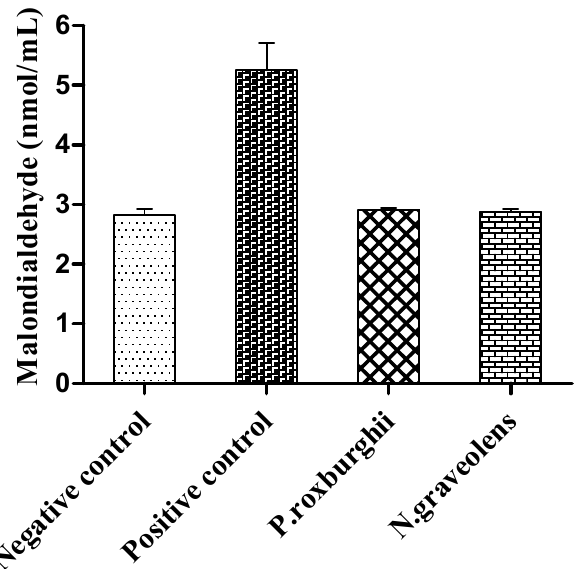
Figure 7. Level of serum malondialdehyde in different groups.